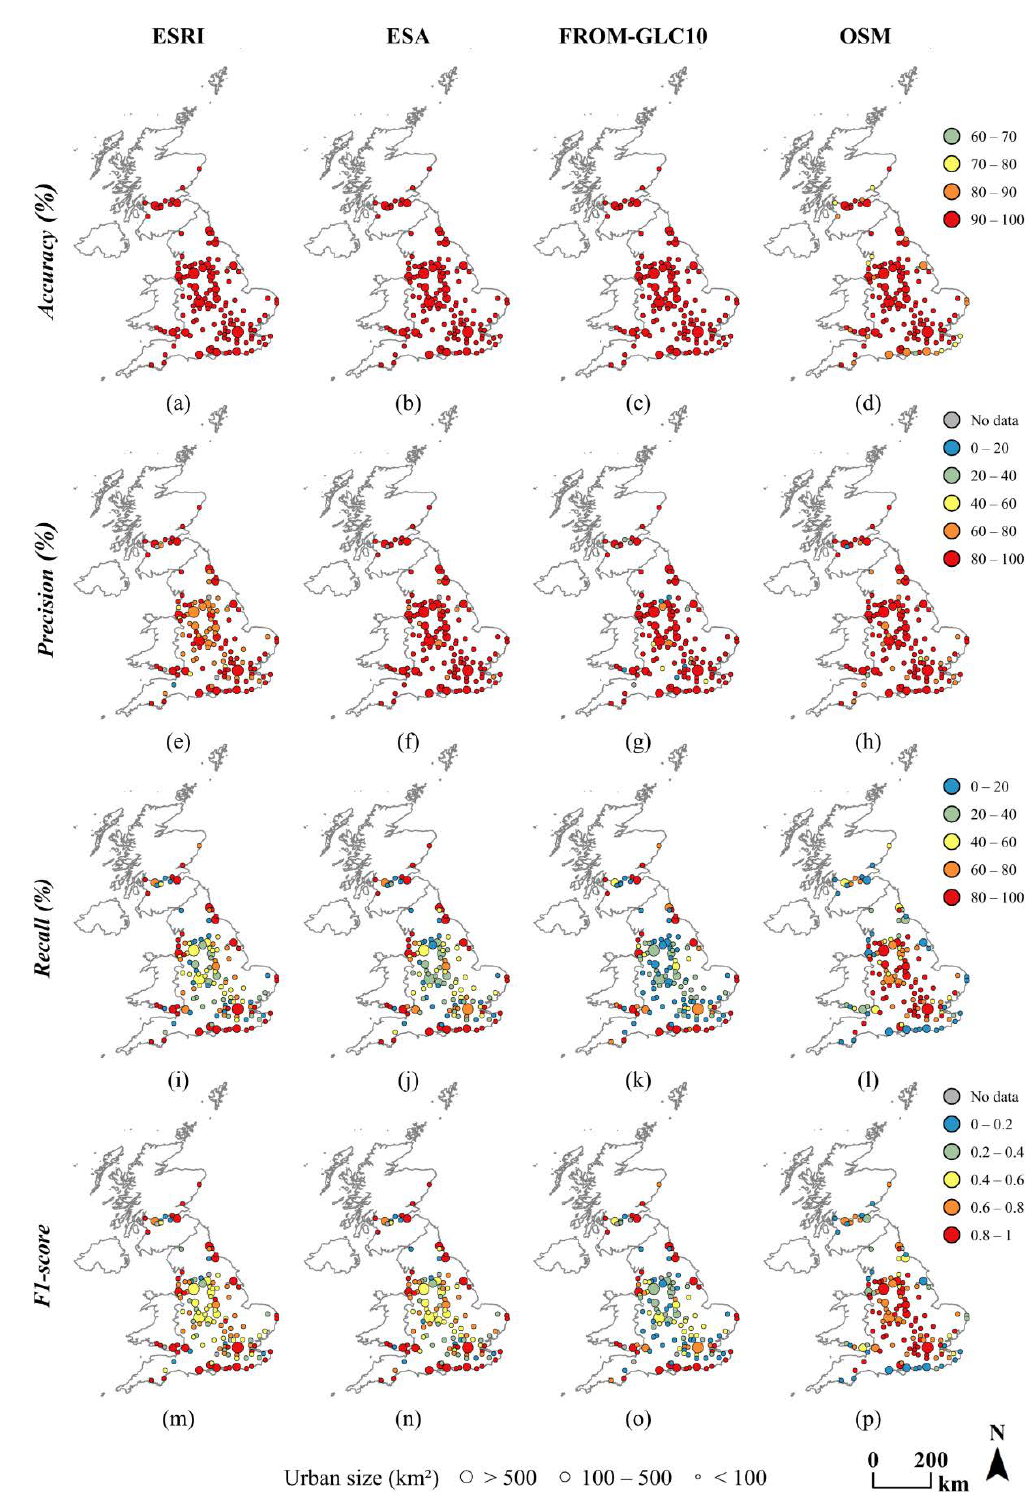
Figure 3. Comparisons of four global open LULC datasets (ESRI, ESA, FROM-GLC10, and OSM) with the reference sub-dataset extracted using a 5-m buffer radius: ( a ) ESRI, accuracy; ( b ) ESA, accuracy; ( c ) FROM-GLC10, accuracy; ( d ) OSM, accuracy; ( e ) ESRI, precision; ( f ) ESA, precision; ( g ) FROM-GLC10, precision; ( h ) OSM, precision; ( i ) ESRI, recall; ( j ) ESA, recall; ( k ) FROM-GLC10, recall; ( l ) OSM, recall; ( m ) ESRI, F1-score; ( n ) ESA, F1-score; ( o ) FROM-GLC10, F1-score; ( p ) OSM, F1-score. “No data” means that no water bodies were identified in that urban area using the corresponding LULC dataset.